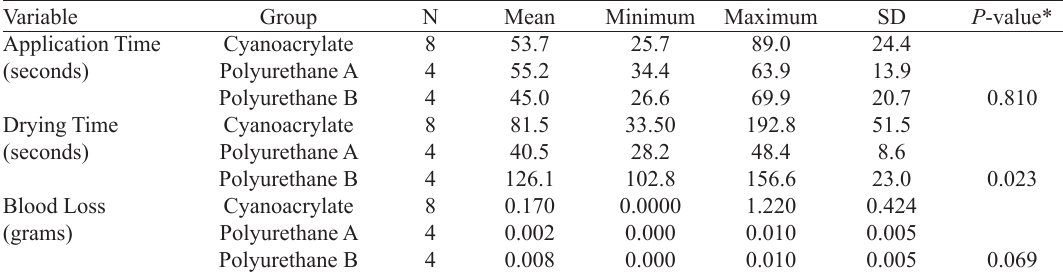
Table 1. Comparison of groups IIA (polyurethane A), IIB (polyurethane B), and III (cyanoacrylate) regarding the intraoperative variables.